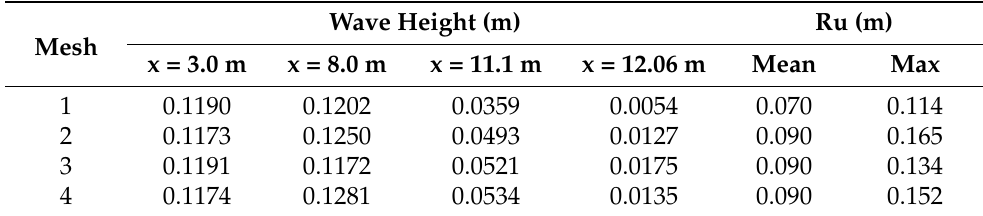
Table 7. Run-up case: mean wave height at gauges located at x = 3.0 8.0, 11.1 and 12.06 m and the mean and maximum run-up obtained in